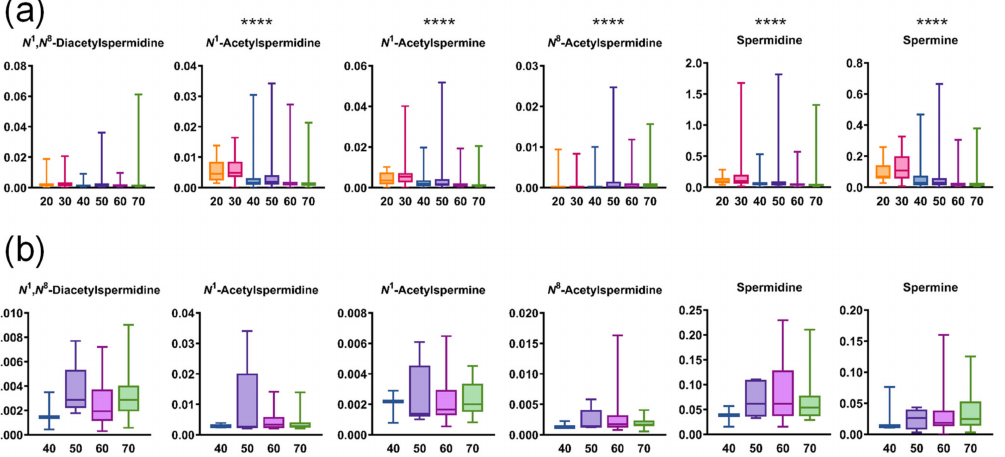
Figure A4. Age-wise differences in salivary polyamine concentrations ( a ) in healthy individuals (20 s, n = 17, 30 s, n = 23, 40s, n = 96, 50 s, n = 97, 60 s, n = 333, and 70 s, n = 358) and ( b ) in patients with pancreatic diseases (40 s, n = 3, 50s, n = 5, 60 s, n = 30, and 70 s, n = 20). Horizontal lines of box plots present 0, 25, 50, 75, and 100% of data. **** p < 0.0001 using the Kruskal–Wallis